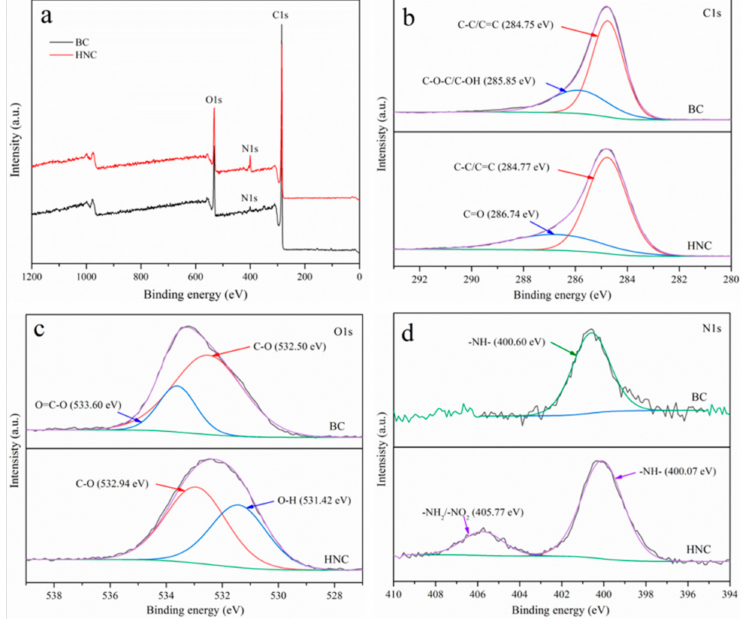
Figure 2. The full XPS spectrum of BC and HNC ( a ); high-resolution XPS spectrum of C1s ( b ), O1s ( c ) and N1s ( d ) of BC and